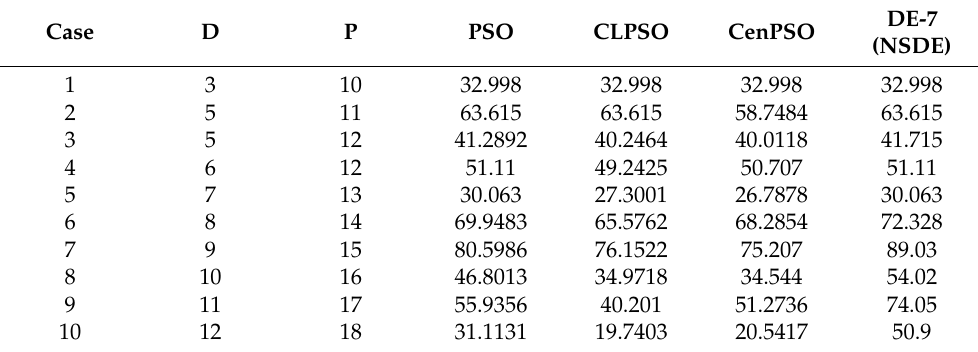
Table 17. Fitness function values for discrete PSO, CLPSO, CenPSO, and DE-7 (NSDE) algorithms with NP = 50; r D = r P =